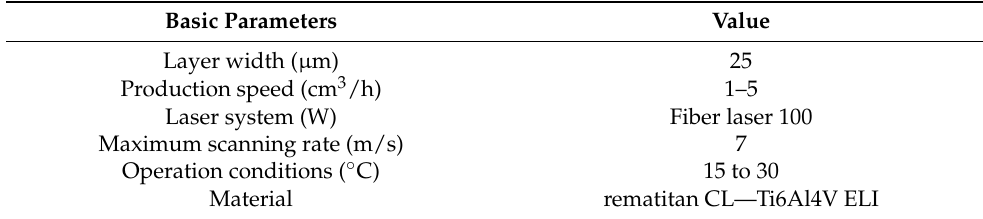
Table 4. The basic parameters of the additive manufacturing selective laser melting (SLM) device settings [26].